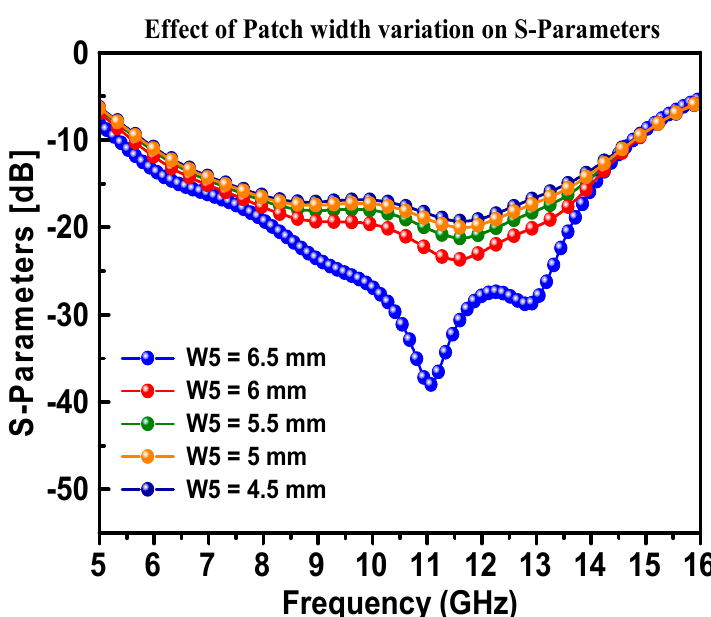
Figure 7. Simulated dependence of the S-Parameters (S11) of the proposed CPW-fed antenna on the changes in patch antenna width (W5).